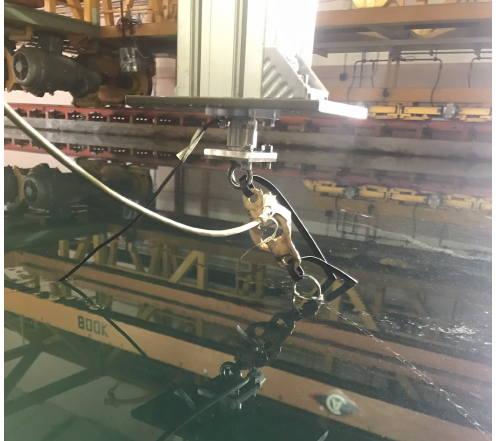
Figure 7. The load cell and dynamometer connection to the aluminum beam attached to the lin- ear